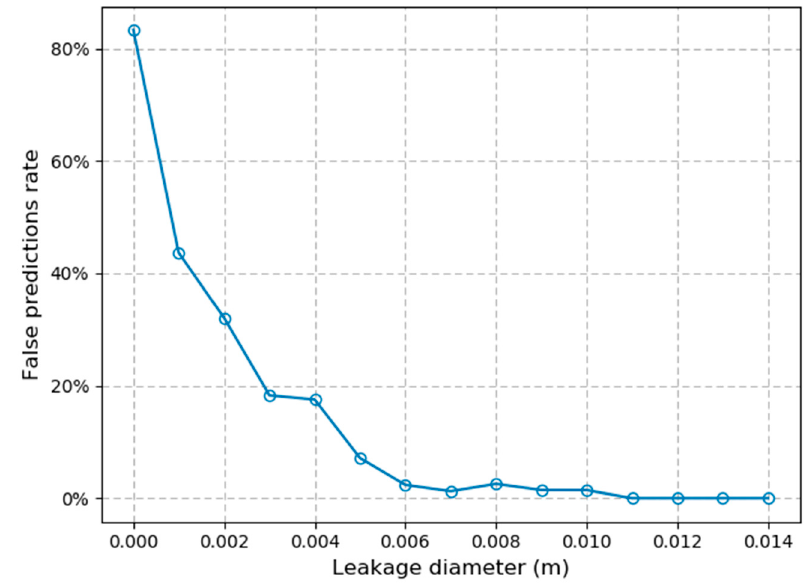
Figure 5. Tnet1 false predictions as a function of leak diameter.